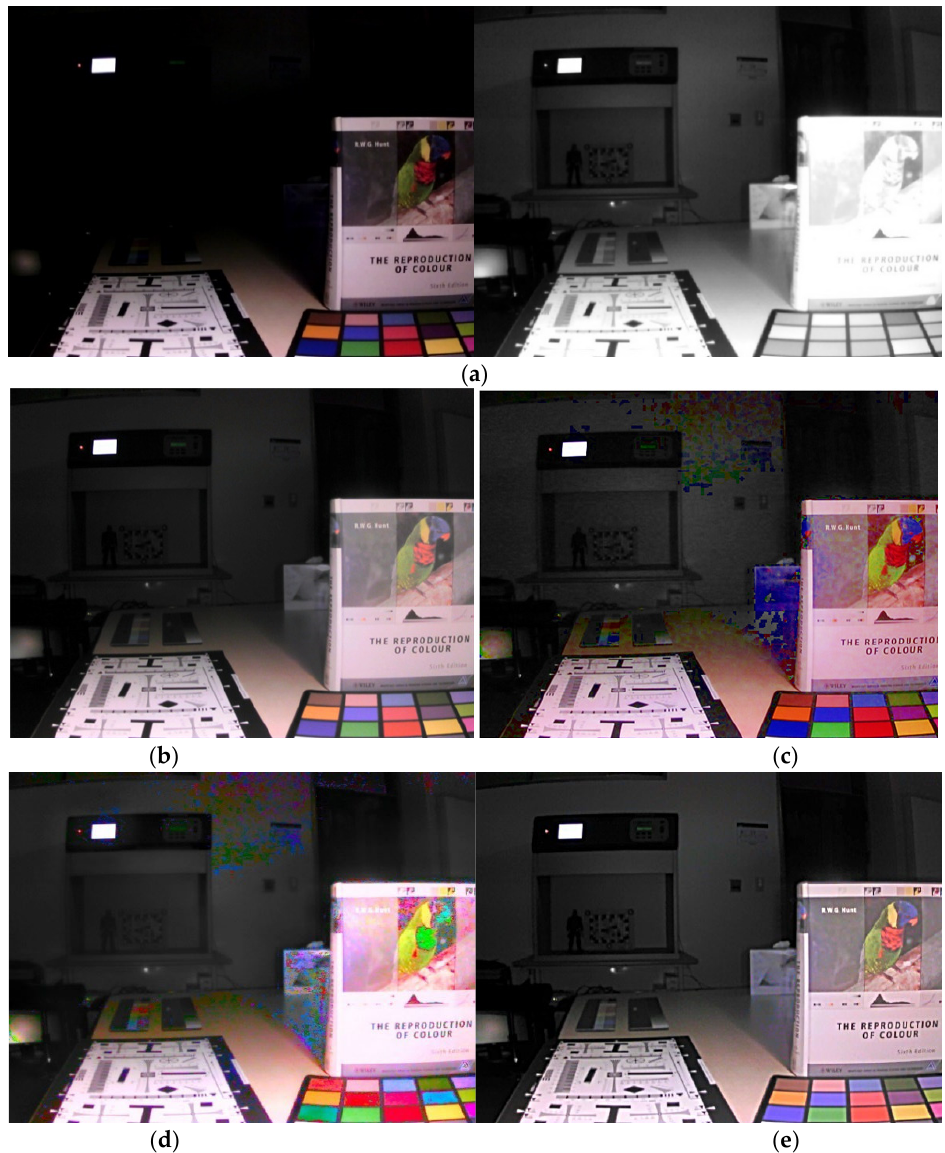
Figure 17. Nighttime input and result images (2): ( a ) visible-light image and near-infrared image, ( b ) Densefuse method result, ( c ) Vanmali method result, ( d ) PCA method result, ( e ) proposed method result.